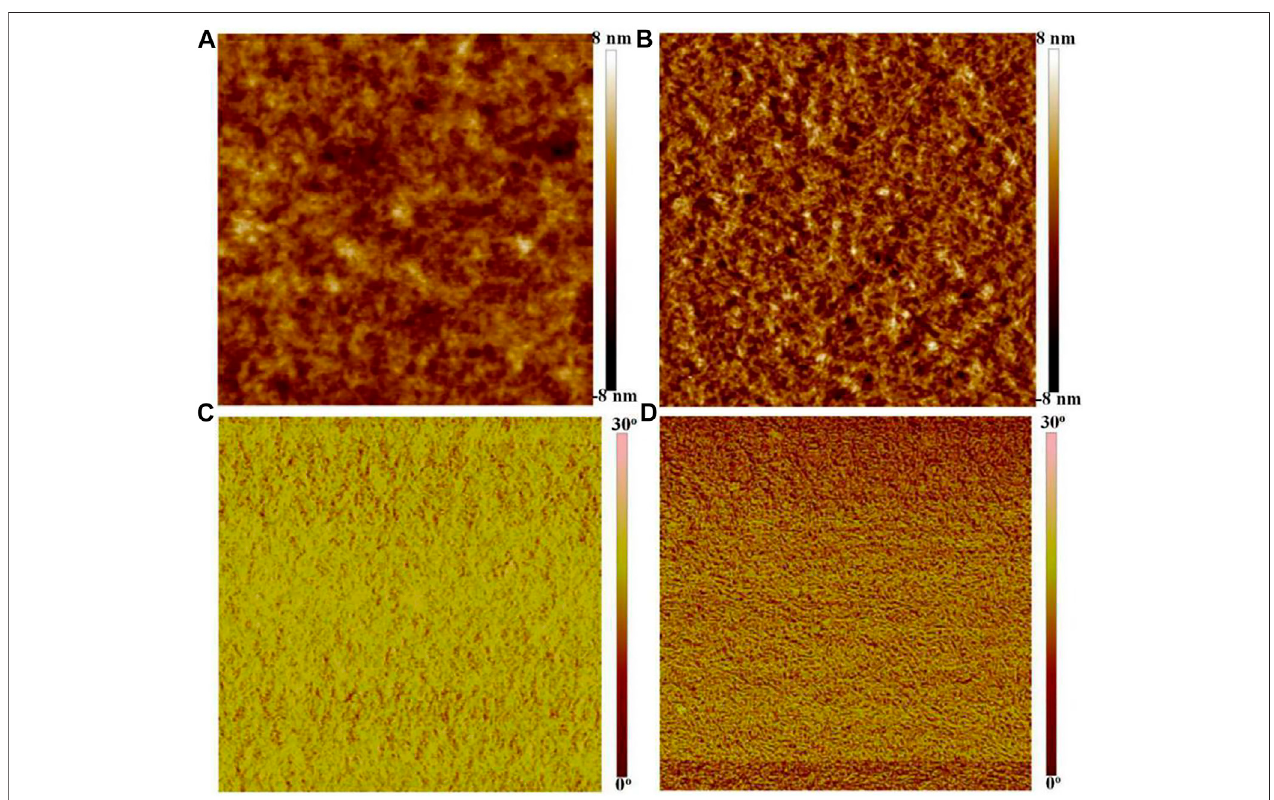
FIGURE 3 | Height and phase images of the pristine fi lms (A,C) and SOCl 2 -treated PEDOT:PSS fi lms (B,D) . Scale bar, 2 μ m × 2 μ m.